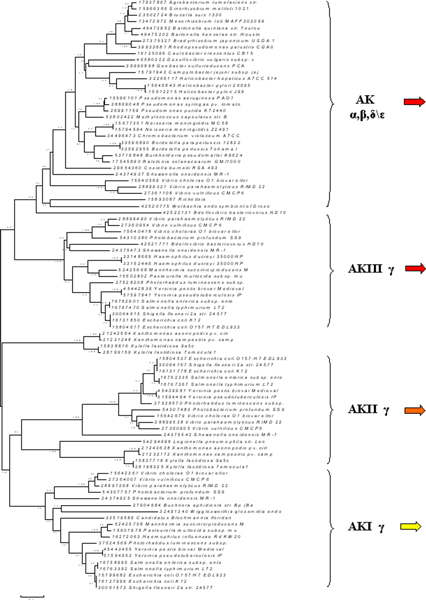
Phylogenetic tree of AK sequences. Phylogenetic trees (Neighbor Joining, 2250 Boostrap Replicates, Complete Deletion, Poisson Correction) constructed with all the retrieved sequences of AK.